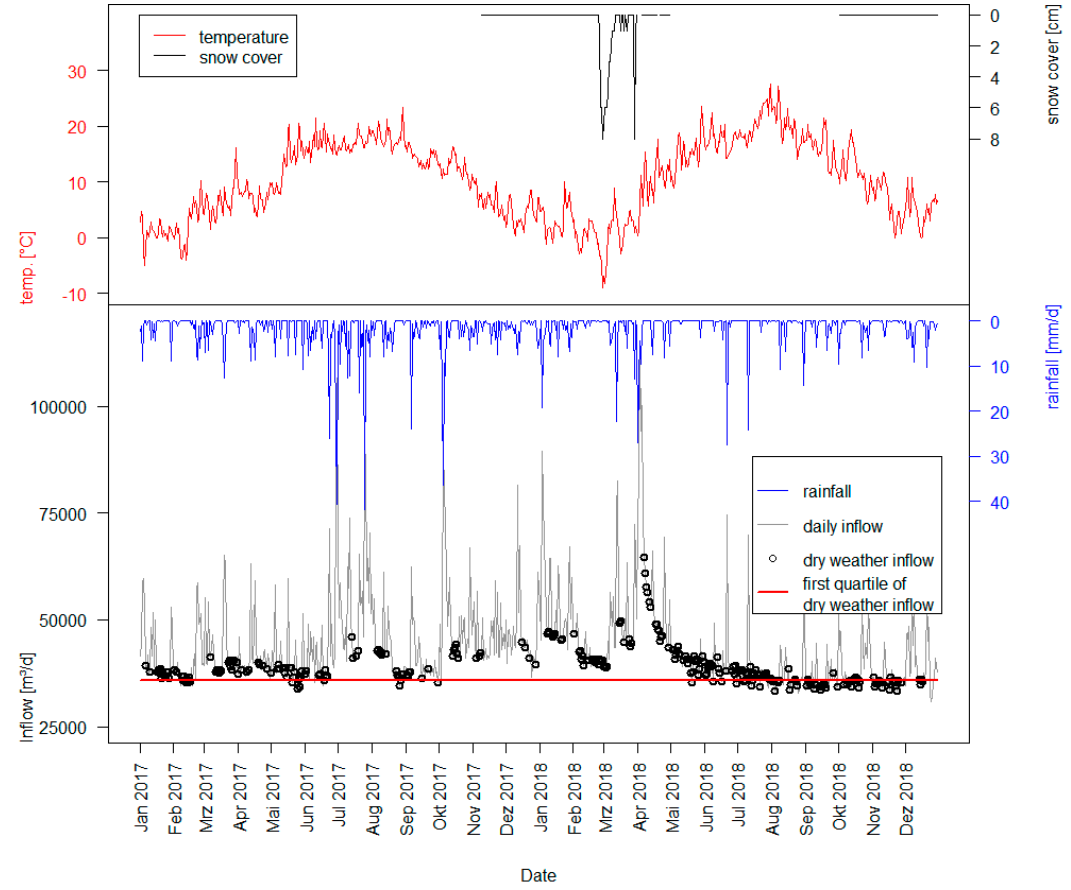
Figure 6. Upper part: temperature and snow cover, measured by German Association for Water, Wastewater and Waste (DWD) in Rostock–Warnemünde [48]; lower Part: inflows to the central WWTP of Rostock in general and at dry weather conditions; the red line (first quartile) is the selected target value for optimization at this WWTP.